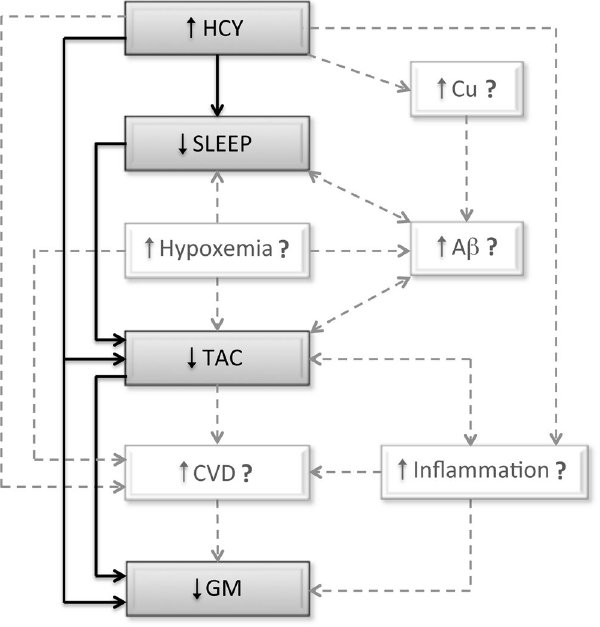
Figure 4. Hypothetical model linking our results with other potentially intervening factors. Gray boxes and black solid arrows are based on findings obtained in the current study; while white boxes and gray dashed arrows refer to other potentially intervening elements derived from alternative evidence. Our findings suggest that the relationship between HCY and TAC levels was mediated by poorer sleep quality in MCI, while the impact of HCY on cerebral GM was mediated by the relationship between sleep quality and TAC levels. Based on previous evidence, we hypothesize that the impact of HCY on TAC levels may be further mediated by copper (Cu) accumulation and/or A β aggregation in the brain, and that sleep disruptions may be additionally prompted by increased hypoxemia, which in turn has also shown to enhance A β burden; whereas the impact of HCY on GM loss may be further mediated by cardiovascular dysfunctions (CVD), which is promoted by multiple factors including elevated HCY, oxidative stress, reduced TAC and low-grade systemic